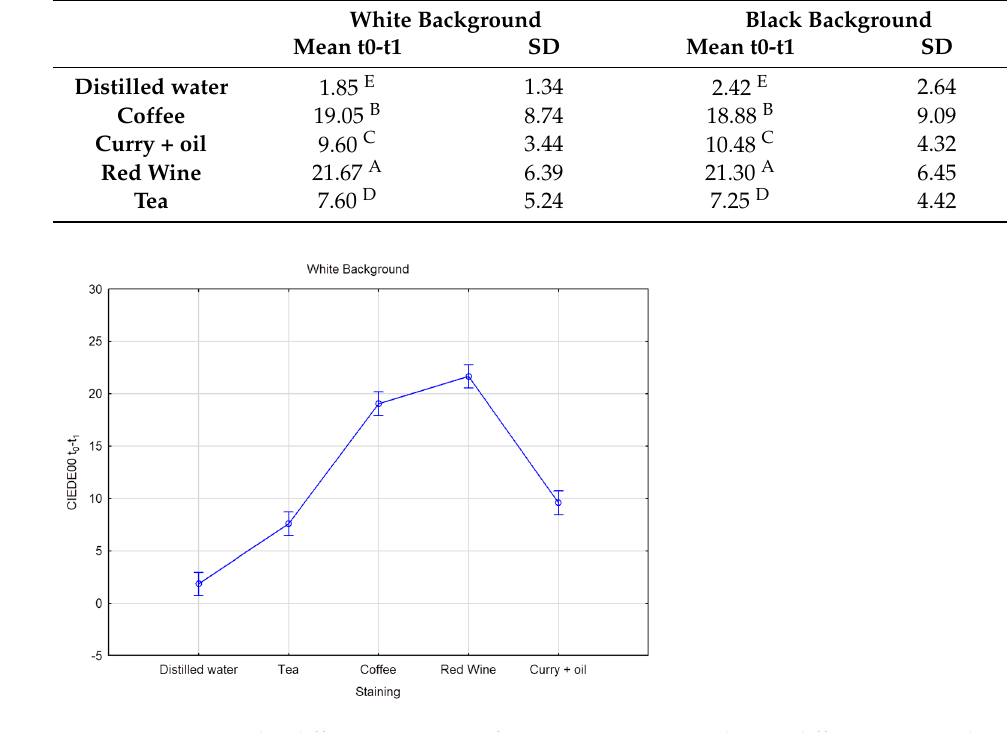
Figure 3. Average color difference in terms of CIEDE00 (t0-t1) according to different staining liquids analyzed over a white background. Vertical bars denote 95% confidence intervals.